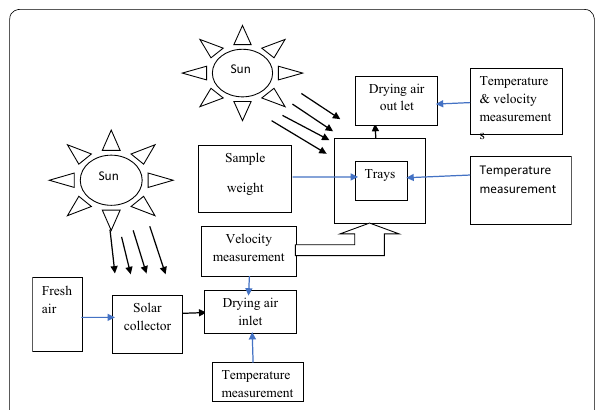
Fig. 28 Flowchart of the solar drying